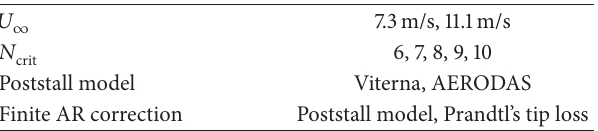
Table 3: Matrix of the parametric study carried out using the extended BEM